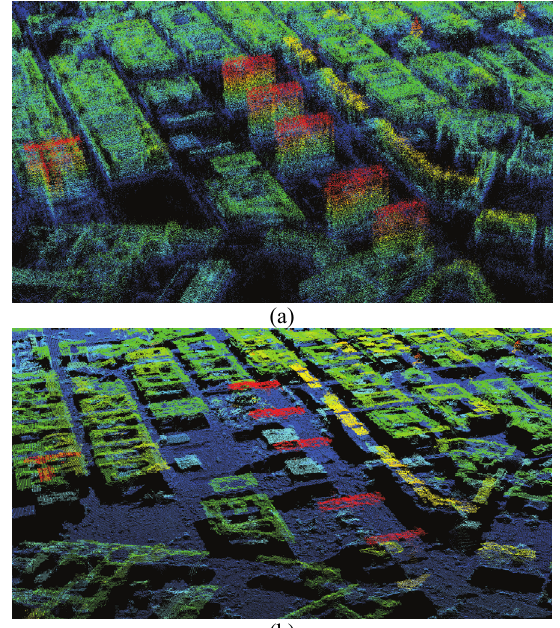
Figure 3. (a) TomoSAR point cloud of high-rise buildings, and (b) the optical point cloud of the same area. Building façades are almost invisible in the optical point cloud, while it is prominent in the TomoSAR point cloud.